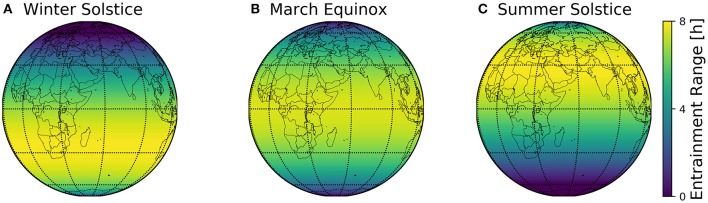
Global entrainment patterns across seasons. Entrainment ranges at different latitudes ϕ are depicted on a globe map for three different times of the year, namely winter solstice (A), March equinox (B), and summer solstice (C). This representation follows the scheme outlined in Figure 2, where the entrainment ranges correspond to those depicted in Figure 6B.